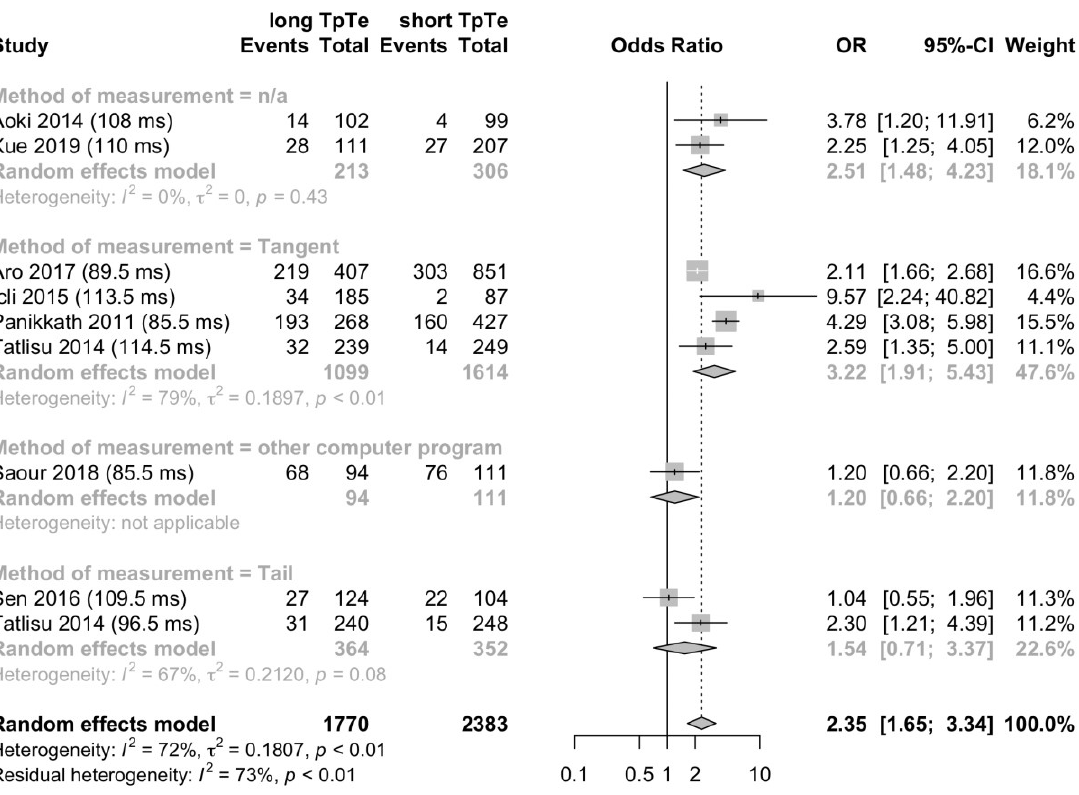
Figure 5. A long T peak -T end interval is associated with all-cause death. This forest plot presents the same studies as Figure 4 but categorized by the ECG measuring method to determine the T peak -T end interval [26,27,33,39,47,48,51,54].